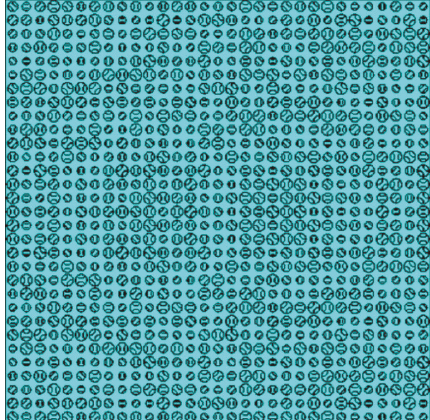
Figure 5: Photograph of the designed 2D device